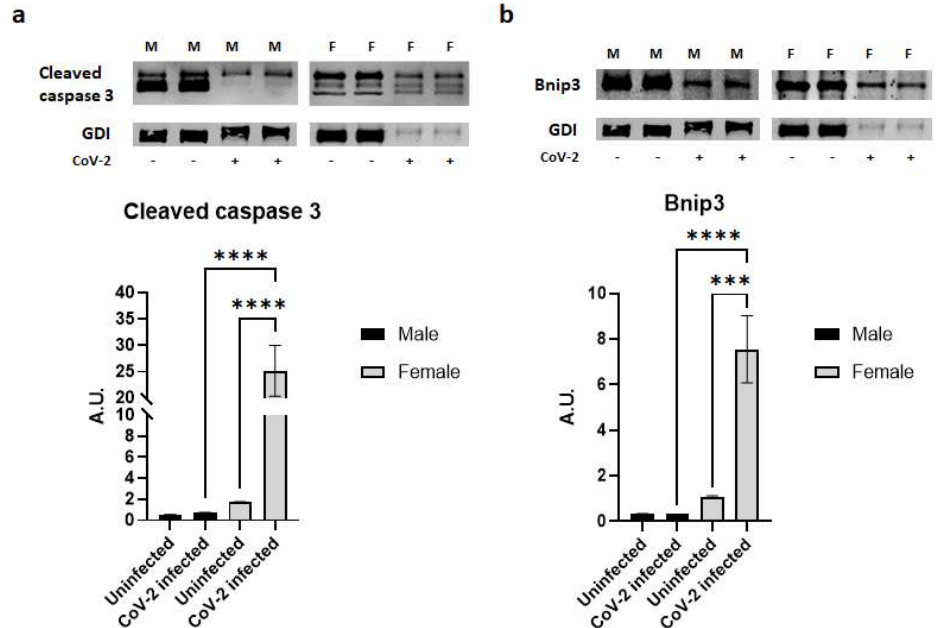
Figure 5. SARS-CoV-2 infection induces severe cell death in adipose tissue in female hACE2 mice. Western blot images of ( a ) Cleaved caspase 3 (apoptosis marker) and ( b ) Bnip3 (necrosis marker). GDI was used as loading control. Fold changes in the protein levels were normalized to GDI expression and are shown as bar graphs. The error bars represent standard error of the mean. *** p < 0.001 and **** p < 0.0001 compared to uninfected sex-matched mice ( n = 4/sex/group) (M, male; F, female).